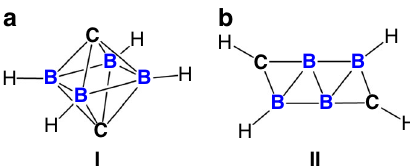
Fig. 1 Global structures of C 2 B 4 H 4 predicted by theoretical calculations. a Three-dimensional octahedron I with two capped carbon atoms. b Two- dimensional ribbon-like structure II